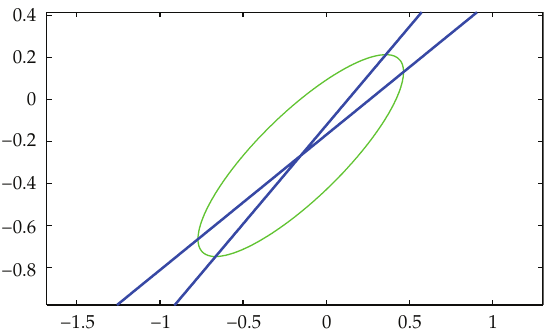
Figure 7: The solution for the system (cid:2) 3.10 (cid:3) over f 1 (cid:2) x (cid:3) ≥ 0 of Example 3.1 is given by the intersection of the two lines at x (cid:7) (cid:2) − 27 / 176 , − 47 / 176 (cid:3)